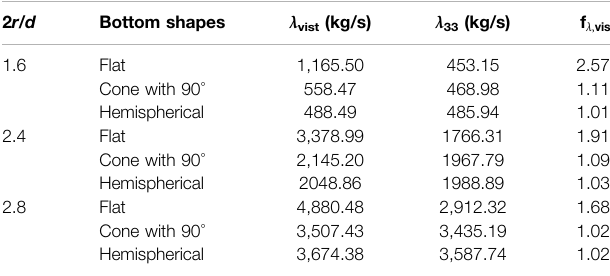
TABLE 2 | Dimension parameters and viscous correction coef fi cients of hemispherical bottom cylindrical WEC. 2 r / d d 0